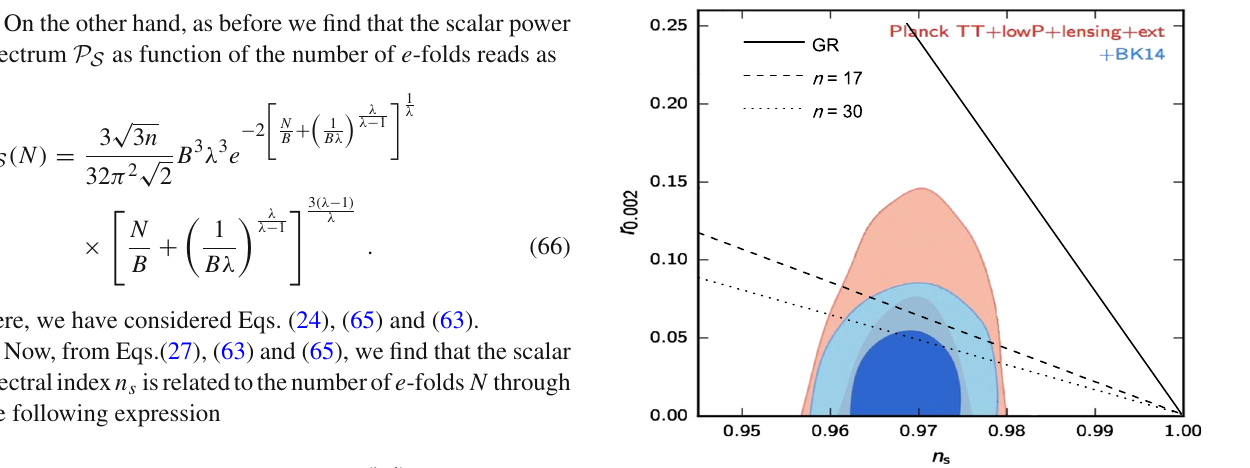
Fig. 2 Thecontour plotforthetensor-to-scalarratio r versus thescalar spectral index n s , for the logamediate expansion in the context of G- inflation. In this plot and from left to right, dotted and dashed lines correspond to the cases when the power n has the values n = 30 and n = 17, respectively. Solid line corresponds to the standard logamedi- ate inflation model. Here, from BICEP2/Keck Array Collaboration, the two- dimensional marginalized constraints (68% and 95% confidence levels) on the consistency relation r ( n s ) [22] are